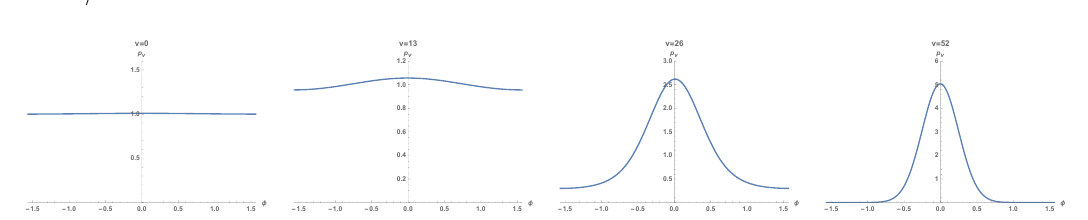
Figure 6 . Dynamical evolution of a perturbed Einstein black ring near y = (cid:0) 1 =R , with m = 2 and m=R = 0 : 98.